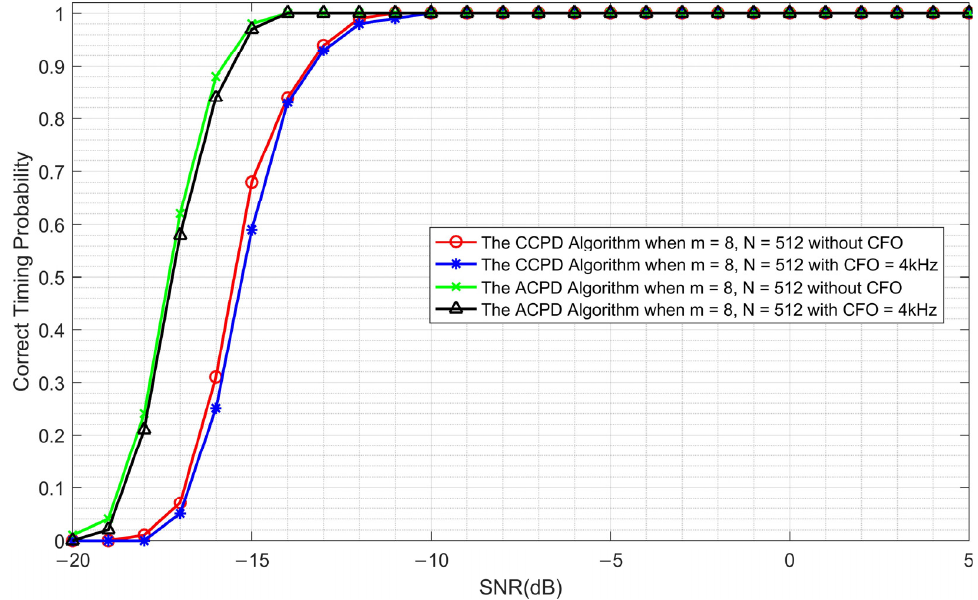
Figure 13. Correct timing probability comparison of the CCPD algorithm and the ACPD algorithm.